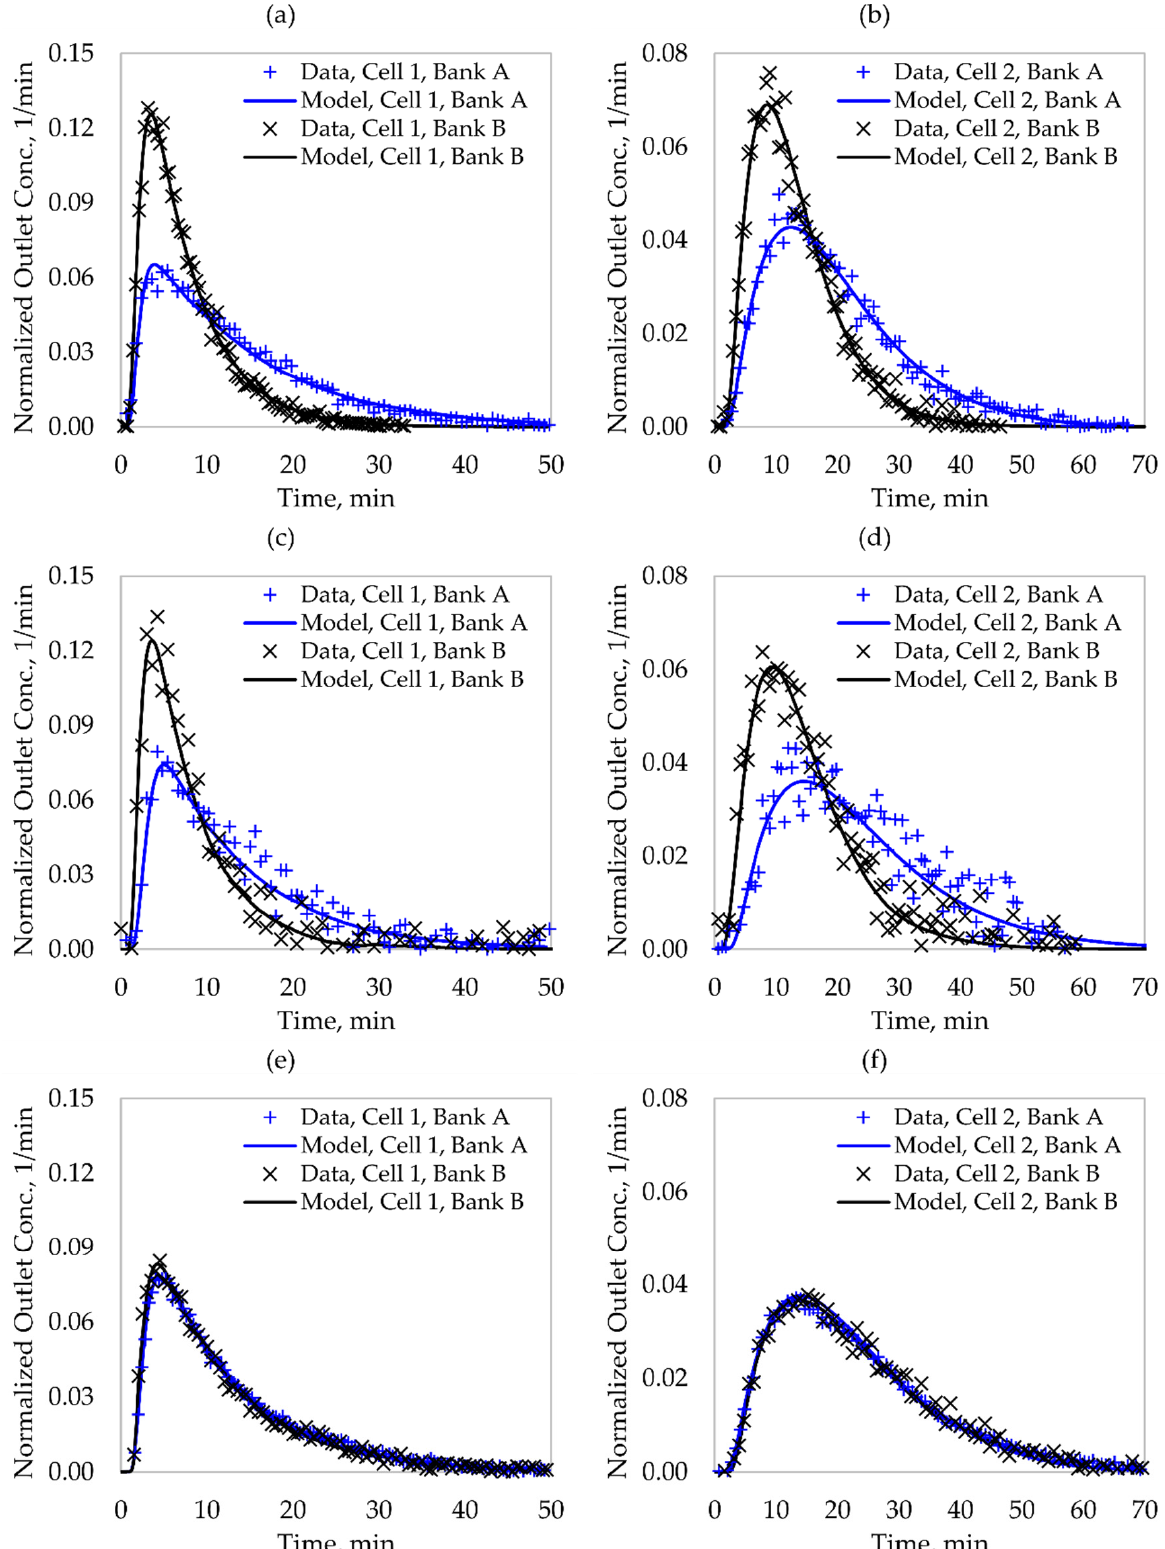
Figure 5. Normalized outlet tracer concentrations: Baseline, coarse solid tracer ( a ) Cell 1, ( b ) Cell 2; Valve Setting 1, medium solid tracer ( c ) Cell 1, ( d ) Cell 2; Valve Setting 2, liquid tracer ( e ) Cell 1, ( f ) Cell 2.